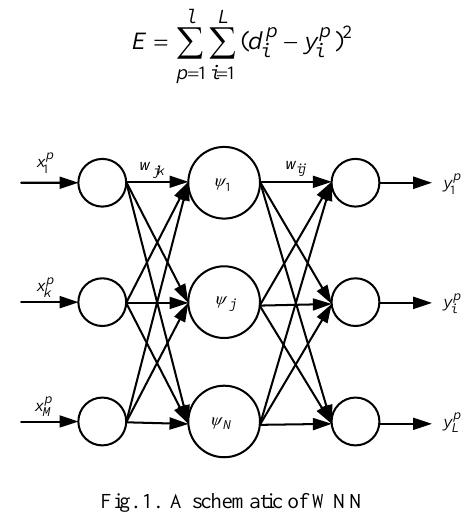
Fig. 1. A schematic of